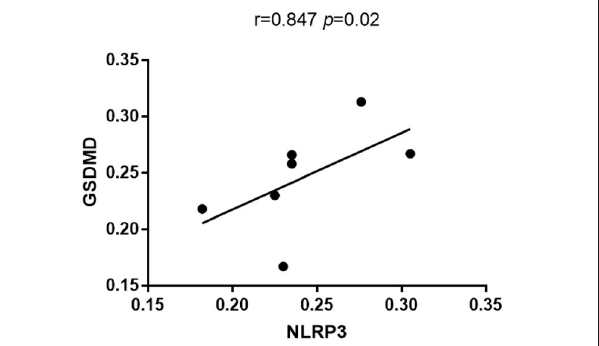
FIGURE 3 | GSDMD expression was positively correlated with that of NLRP3.